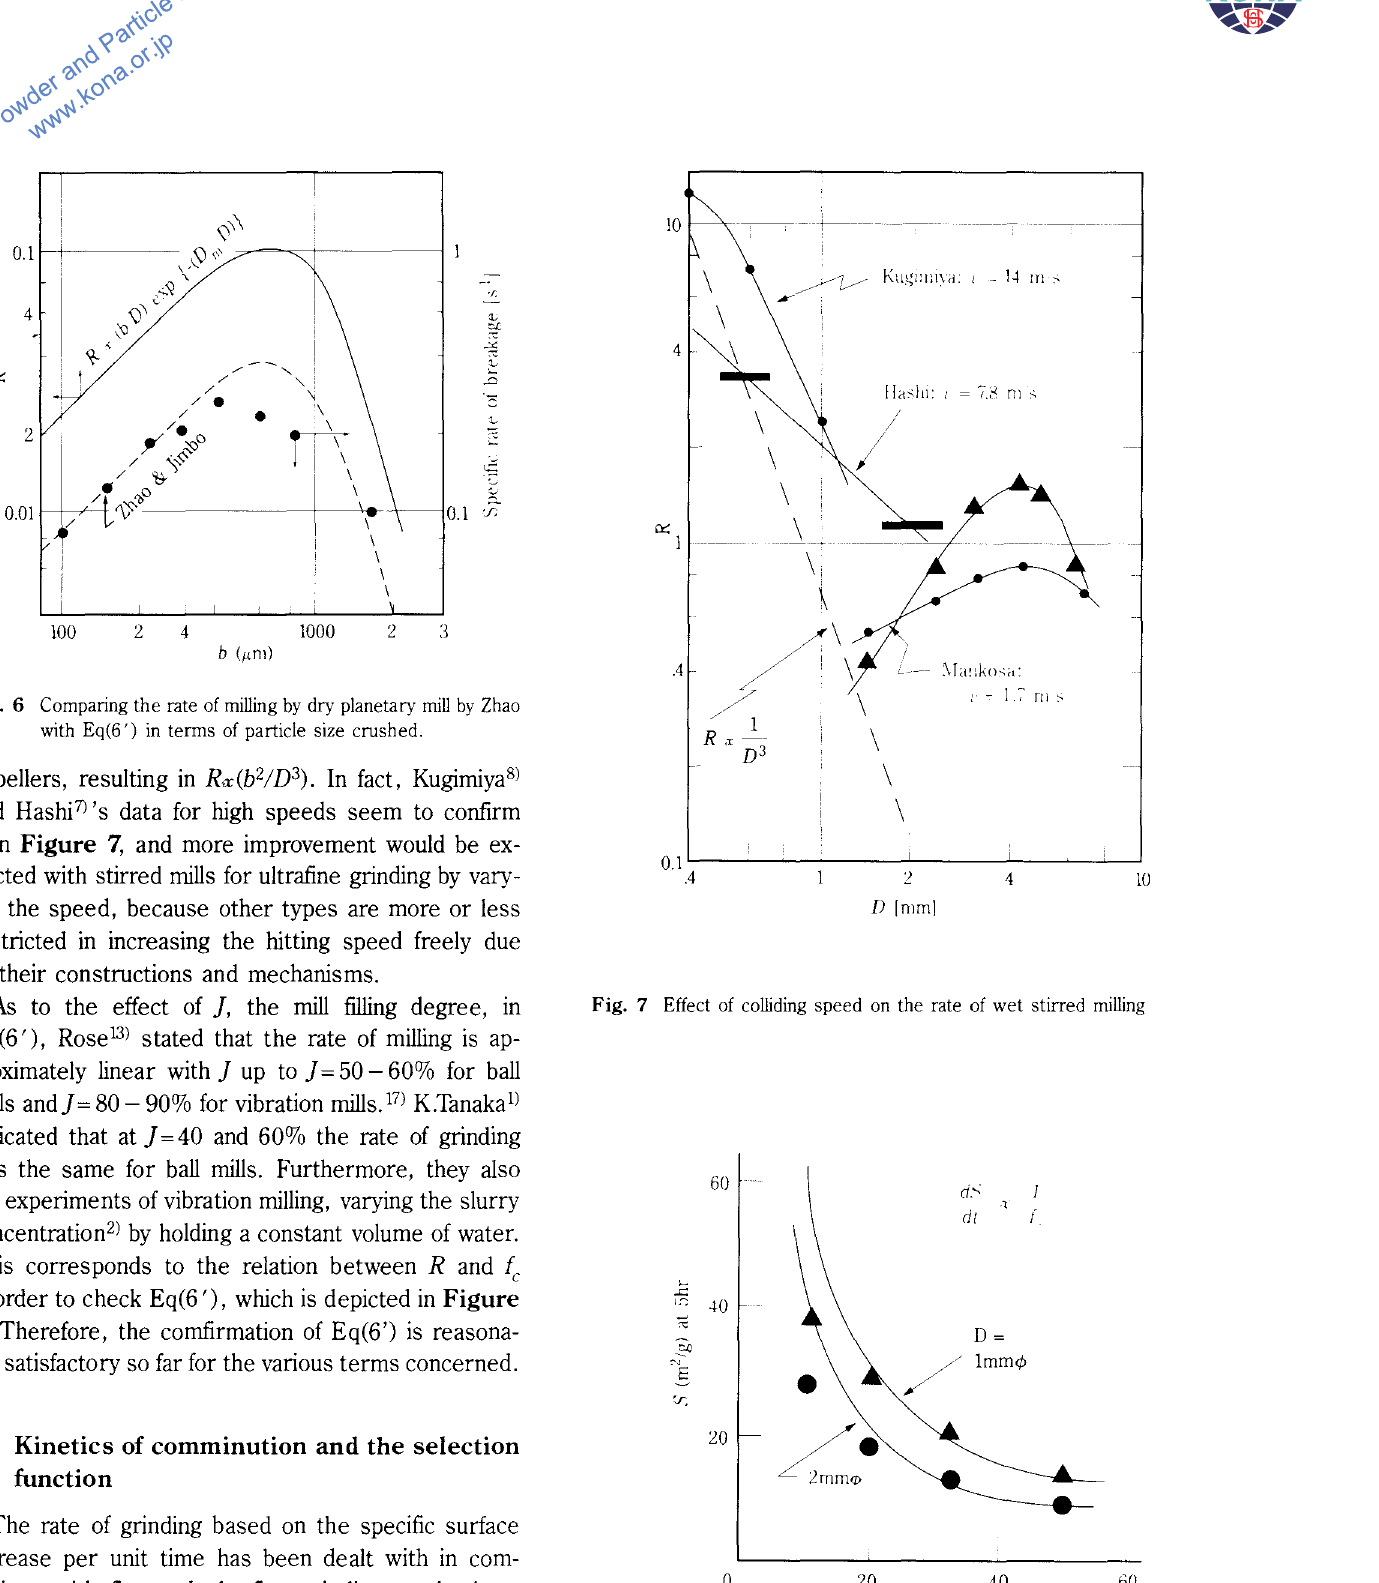
Fig. 8 Rate of vibration milling by K.Tanaka compared with Eq(6 ') in terms of the fractional powder filling which is propor tional to the slurry concentration balance is taken, where agglomeration of fine particles is negligible,